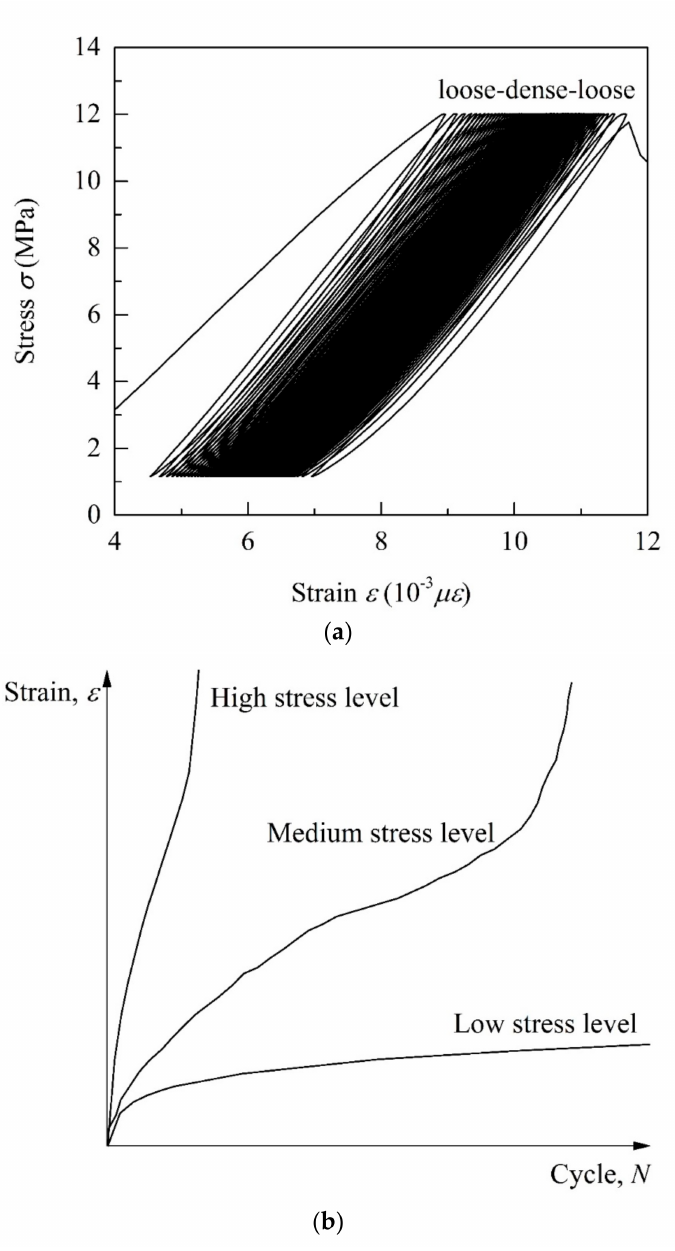
Figure 1. Classical fatigue damage evolution: ( a ) stress–strain curve under cyclic loading; and ( b ) classification of development curves of irreversible